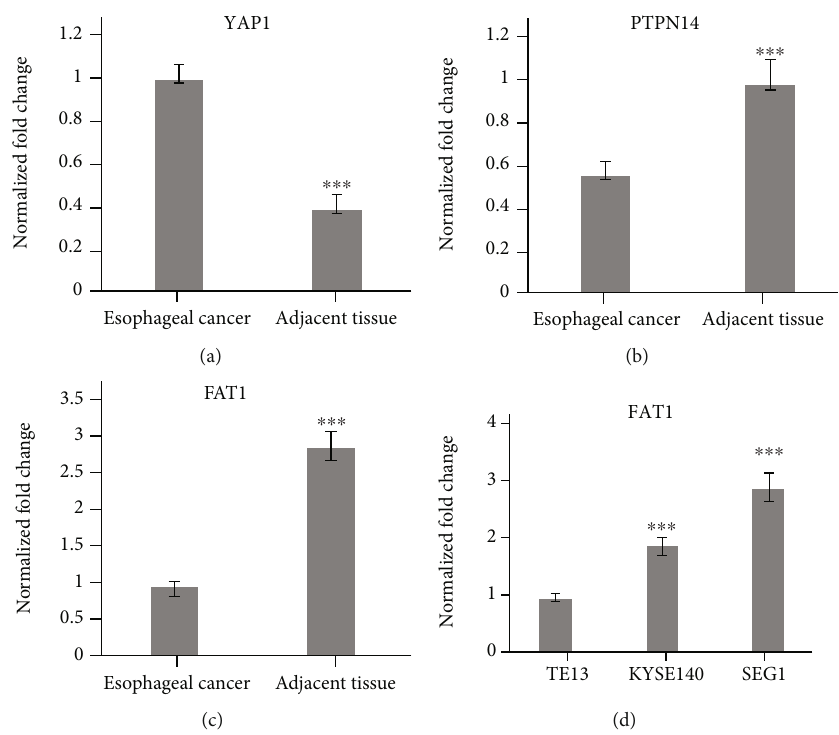
Figure 1: The mRNA expression of Yap1 PRPN14 and FAT1 in esophageal cancer. (a) Yap1 mRNA was highly expressed in the tissues of esophageal carcinoma ( n = 20 ), but low in esophageal carcinoma adjacent tissues ( n = 20 ). The expression of PTPN14 (b) and FAT1 (c) was low in the tissues of esophageal carcinoma, but high in the adjacent tissues of esophageal carcinoma. (d) FAT1 was highly expressed in the SEG1, but low in TE13. ∗∗∗ P < 0 : 001 vs. the EC tissue. ### P < 0 : 001 vs.